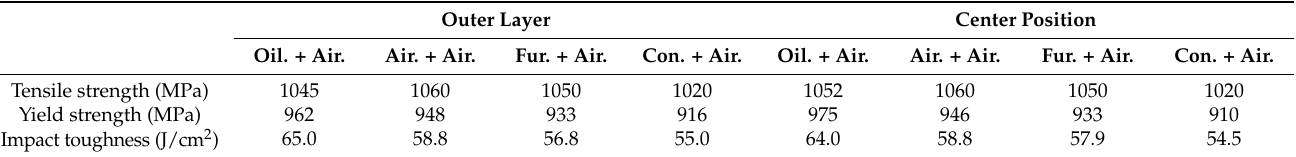
Table 5. Effect of quenching cooling rate on mechanical properties at 1040 ◦ C during quenching and tempering. Outer Layer Center Position Oil. + Air. Air. + Air. Fur. + Air. Con. + Air. Oil. + Air. Air. + Air. Fur. + Air. Con. + Air.